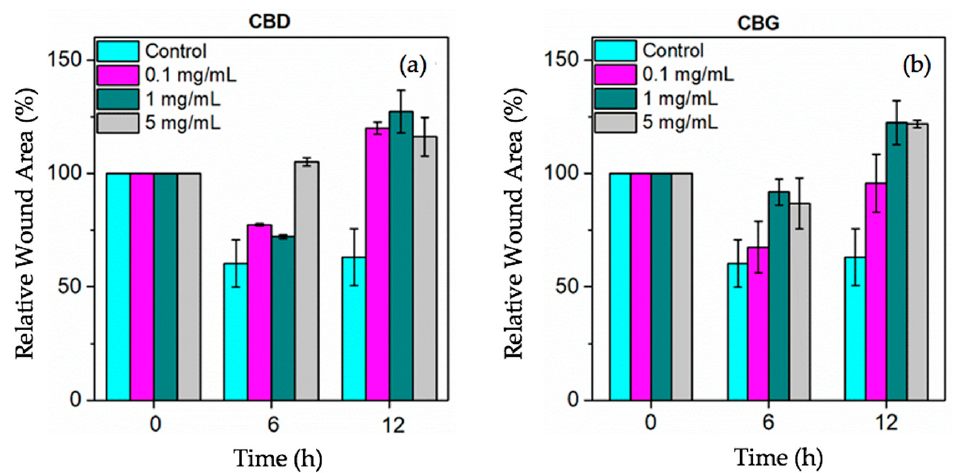
Figure 11. Relative Wound Area calculated by the in vitro wound-healing assay for ( a ) CBD and ( b ) CBG nanoparticles in various concentrations (0.1, 1 or 5 mg/mL).